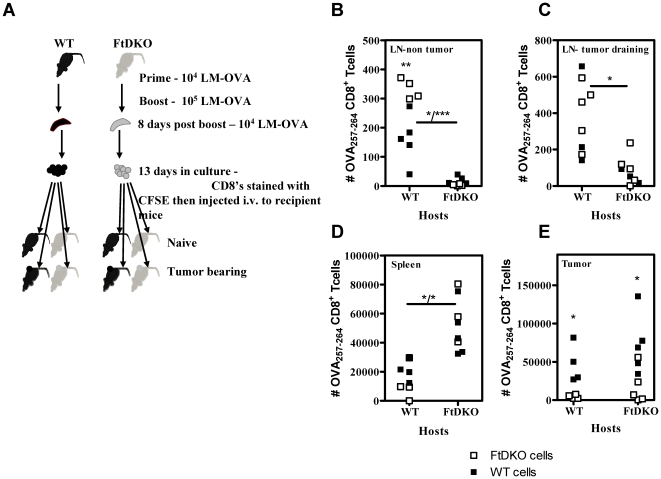
Migration of Adoptively transferred antigen-specific CD8+ T cells.Adoptive transfer experiment was carried as indicated in the schematic diagram (A). Purified CD8+ T cells from in-vitro antigen-dependant expansion of cultures (comprising 1×106 OVA257–264-specific CD8+ T cells) were transferred intravenously into naïve or tumor bearing recipient mice (tumor size, 45–90 mm2) , and donor cells in the various organs of recipients were enumerated 4 days later. Number of OVA257–264-specific CD8+ T cells in individual mice recovered from non-tumor bearing lymph nodes (B), tumor bearing lymph nodes (C) tumor bearing spleen (D) and tumor (E) of recipient WT or FtDKO mice is indicated. (B), *, WT cells in FtDKO compared to WT hosts, p = 0.02; ***, FtDKO cells in FtDKO compared to WT hosts, p = 0.0003; **, FtDKO cells compared to WT cells in WT hosts; p = 0.008. (C), *, FtDKO cells in different hosts, p = 0.011. (D), *, WT cells in different hosts, p = 0.03; * FtDKO cells in different hosts, p = 0.036. (E), *, WT cells compared to FtDKO cells in WT hosts, p = 0.034; *, FtDKO versus WT cells in FtDKO hosts, p = 0.043. Data were analyzed by unpaired t test.